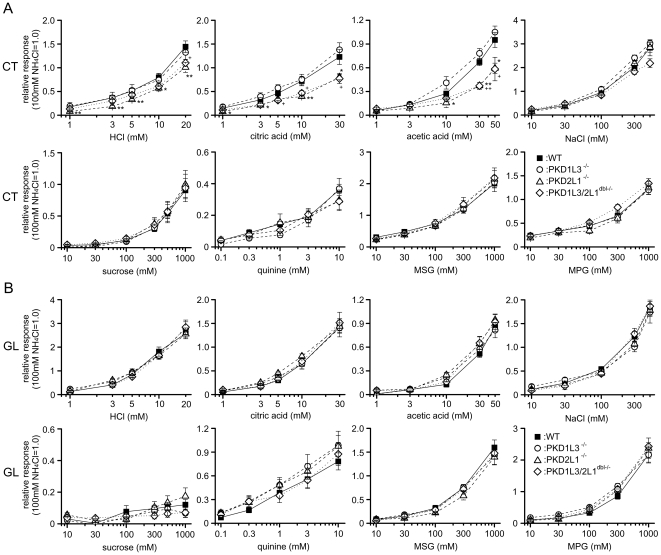
Concentration-response relationships of CT and GL nerveresponses.Concentration-response relationships of CT (A) and GL(B) nerve responses of WT [black rectangle,n = 8 (CT) and 8 (GL)],PKD1L3−/− [white circle,n = 5 (CT), and 6 (GL)],PKD2L1−/− [white triangle,n = 7 (CT) and 6 (GL)], andPKD1L3/2L1dbl−/− mice [white diamond,n = 6 (CT) and 6 (GL)] for HCl, citric acid,acetic acid, NaCl, sucrose, quinine, MSG, and MPG. Gustatory nerveresponses were normalized to the response to 100 mM NH4Cl.Values indicated are means ± S.E.M. Statistical differences wereanalyzed by ANOVA tests (see Table 3) and posthoc Dunnett's tests (*: P<0.05, **:P<0.01 for PKD2L1−/−; +:P<0.05, ++: P<0.01 forPKD1L3/2L1dbl−/−).